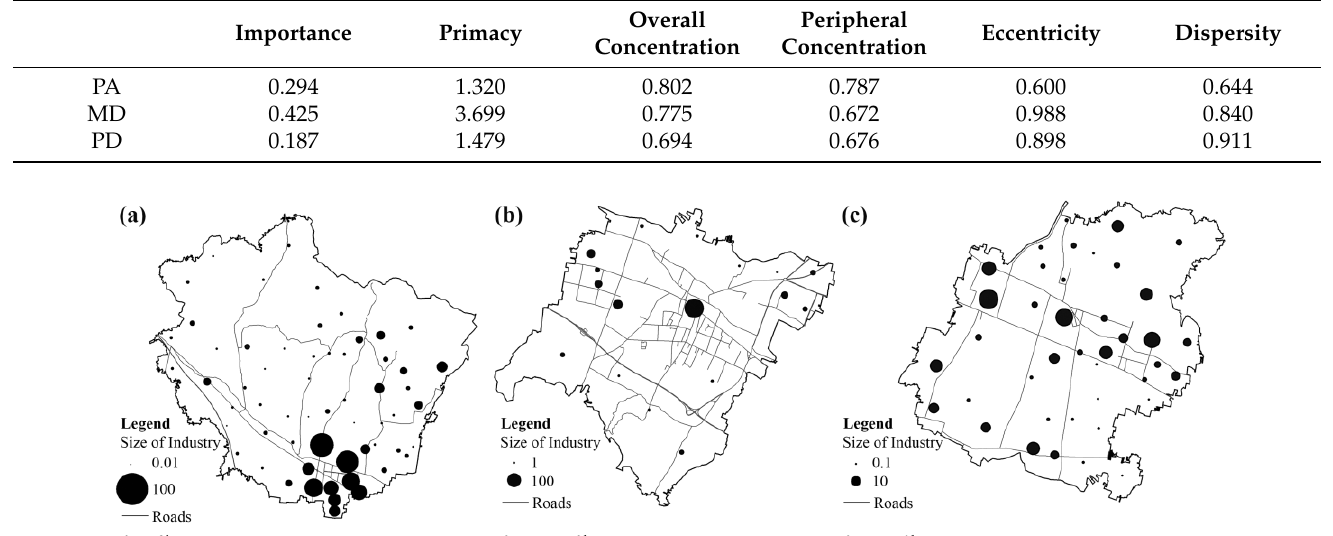
Table 4. Centers of the three clusters